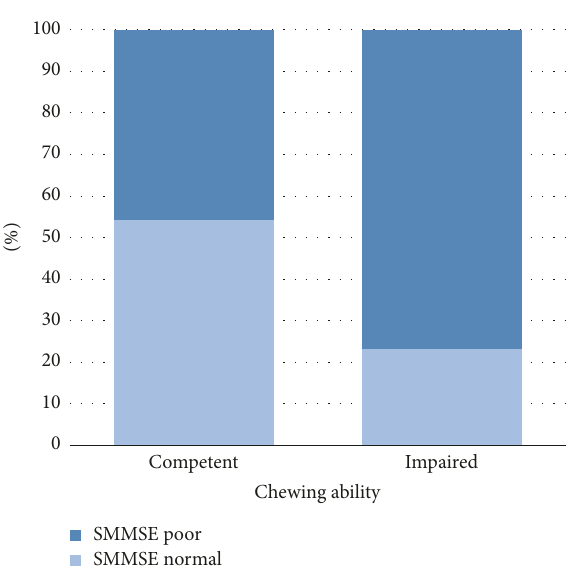
Figure 1: Prevalence of normal SMMSE or low SMMSE score according to the number of remaining teeth.